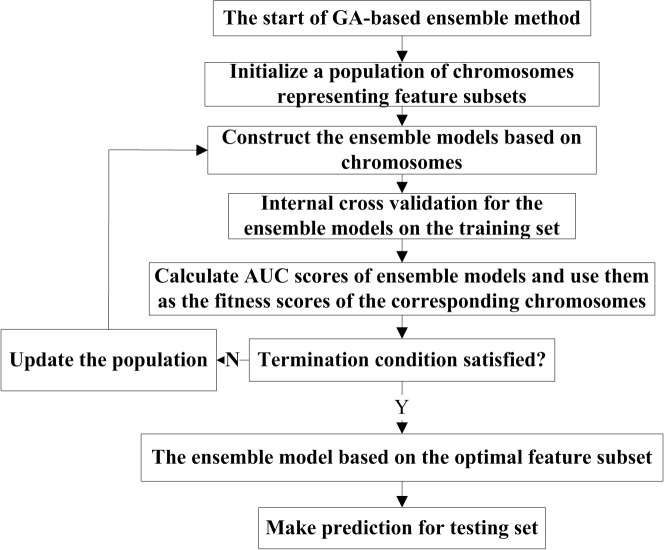
The flowchart of GA-based ensemble method.